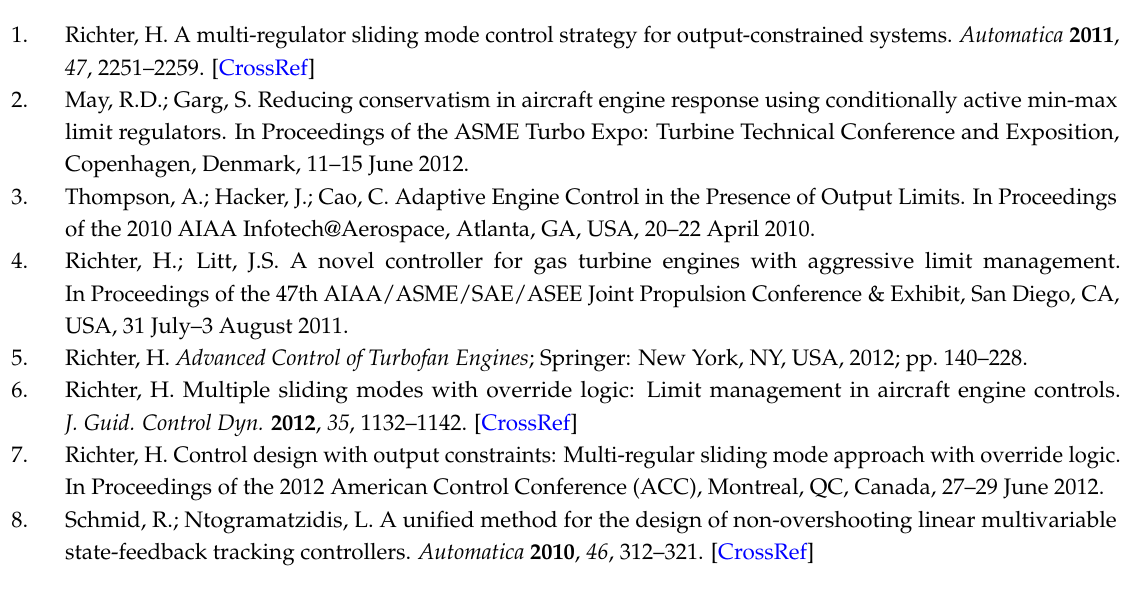
Figure 10. Control rates with OAMTC limit regulator.